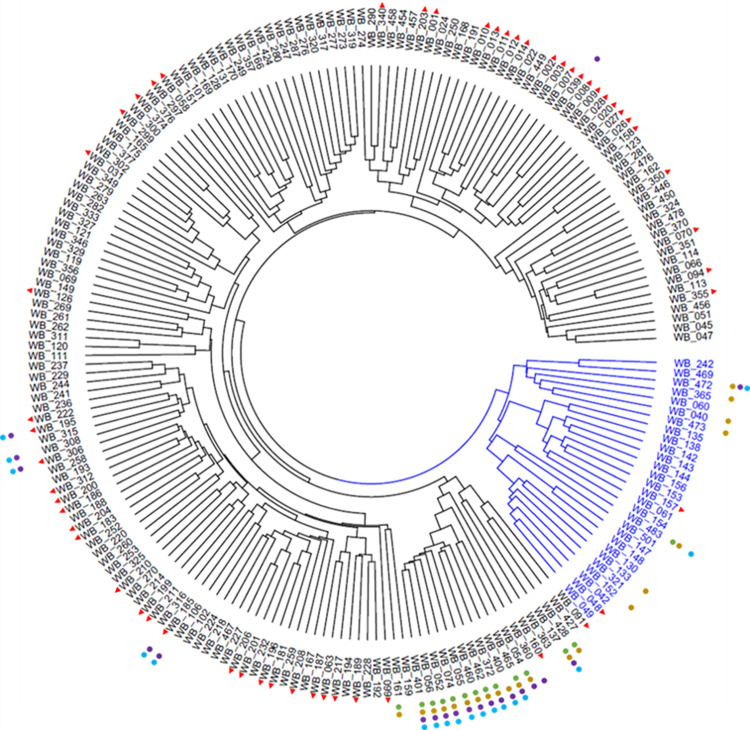
Hierarchical cluster analysis of the 201 Hordeum vulgare accessions of the GWA-panel based on the Rogers‘ distance.The identified subpopulation of 28 genotypes is highlighted in blue, modern material is labeled with red arrow-heads and carriers of the resistant alleles are indicated with colored dots: green–CG_1; ochre–CG_2; violet–CG_3; blue–CG_4.